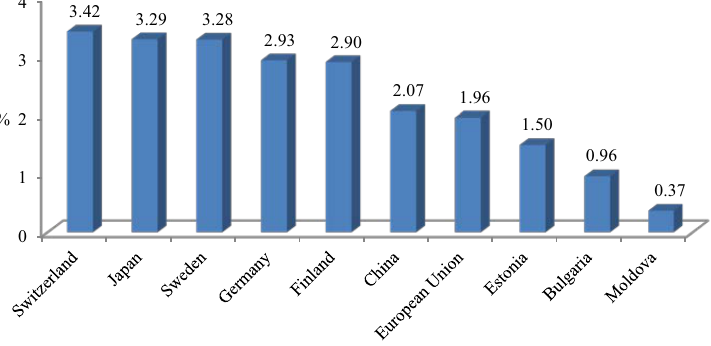
Fig. 1. Gross domestic spending on R&D, percentage of GDP, 2015 Source : OECD